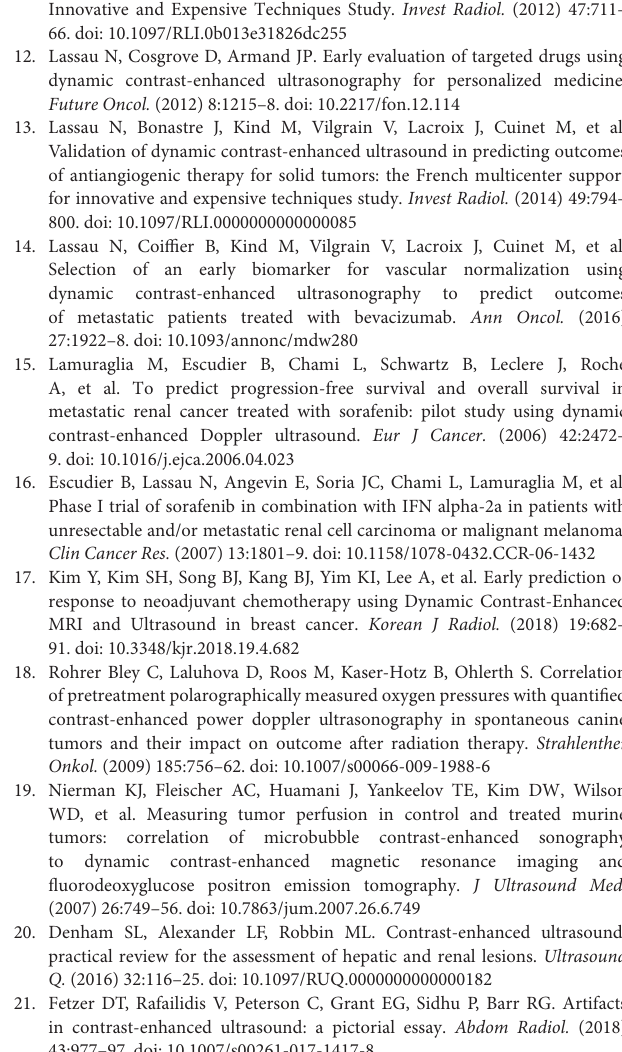
Figure 2 . Language editing services for this manuscript were provided by American Journal